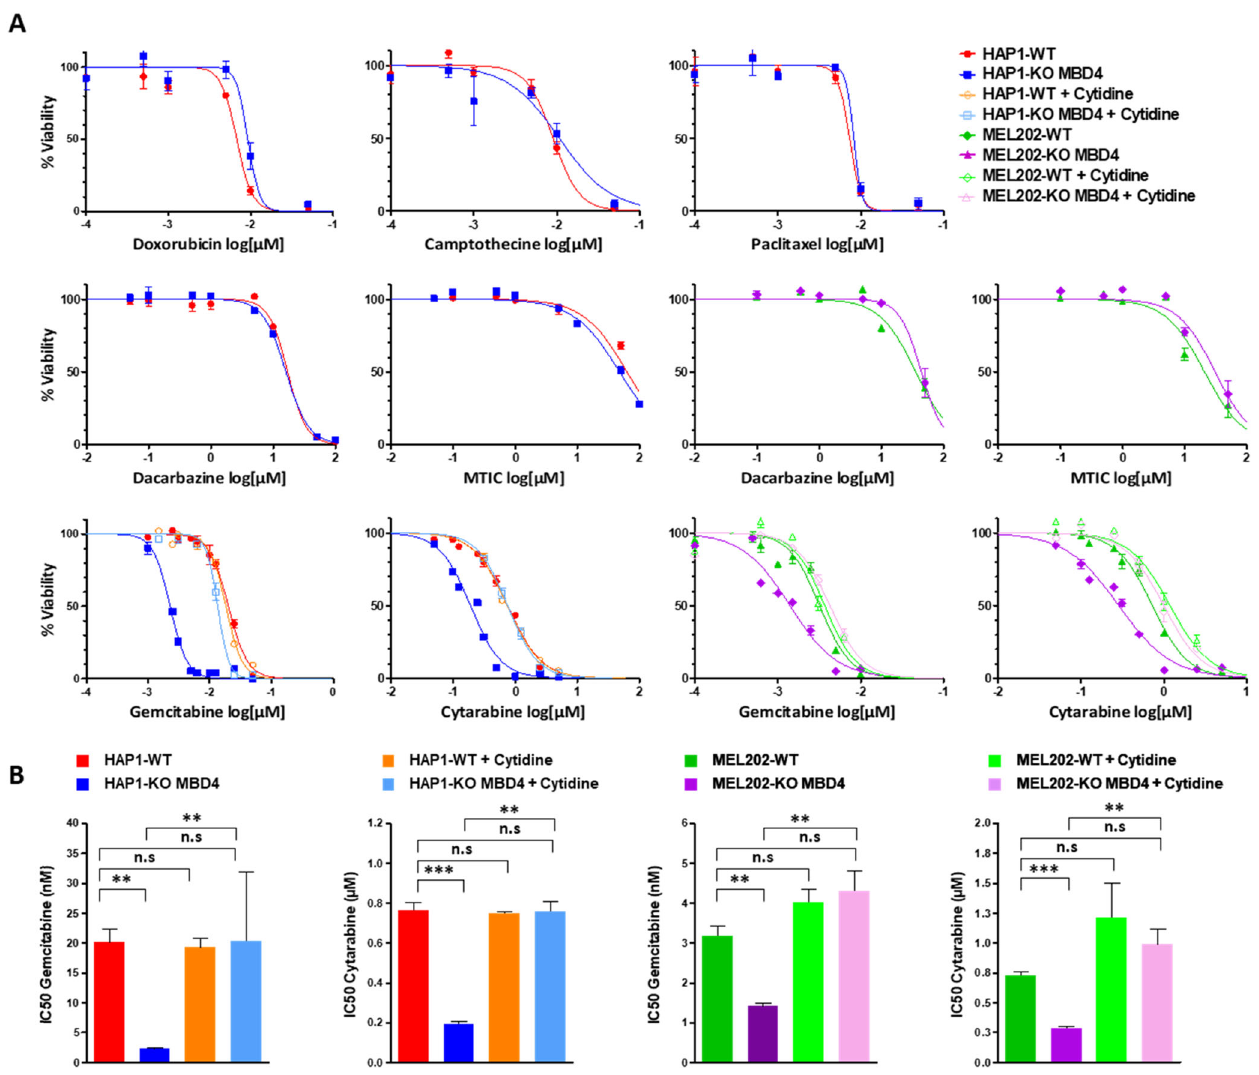
Fig. 2 MBD4-de fi cient cell lines are more sensitive to gemcitabine and cytarabine than MBD4-pro fi cient counterparts. A Cell count assay assessing cell viability of HAP1 and MEL02 isogenic cell lines. B IC 50 for each culture condition of HAP1 and MEL202 isogenic cell lines was obtained from a dose-response curve ( n = 3, mean ± SD). Cell count and IC 50 were calculated from three independent assays for each condition. Cytidine addition (2 µM fi nal) or not is indicated. n.s non-signi fi cant; ** P < 0.01; *** P < 0.001; unpaired two-sided Student ’ s t